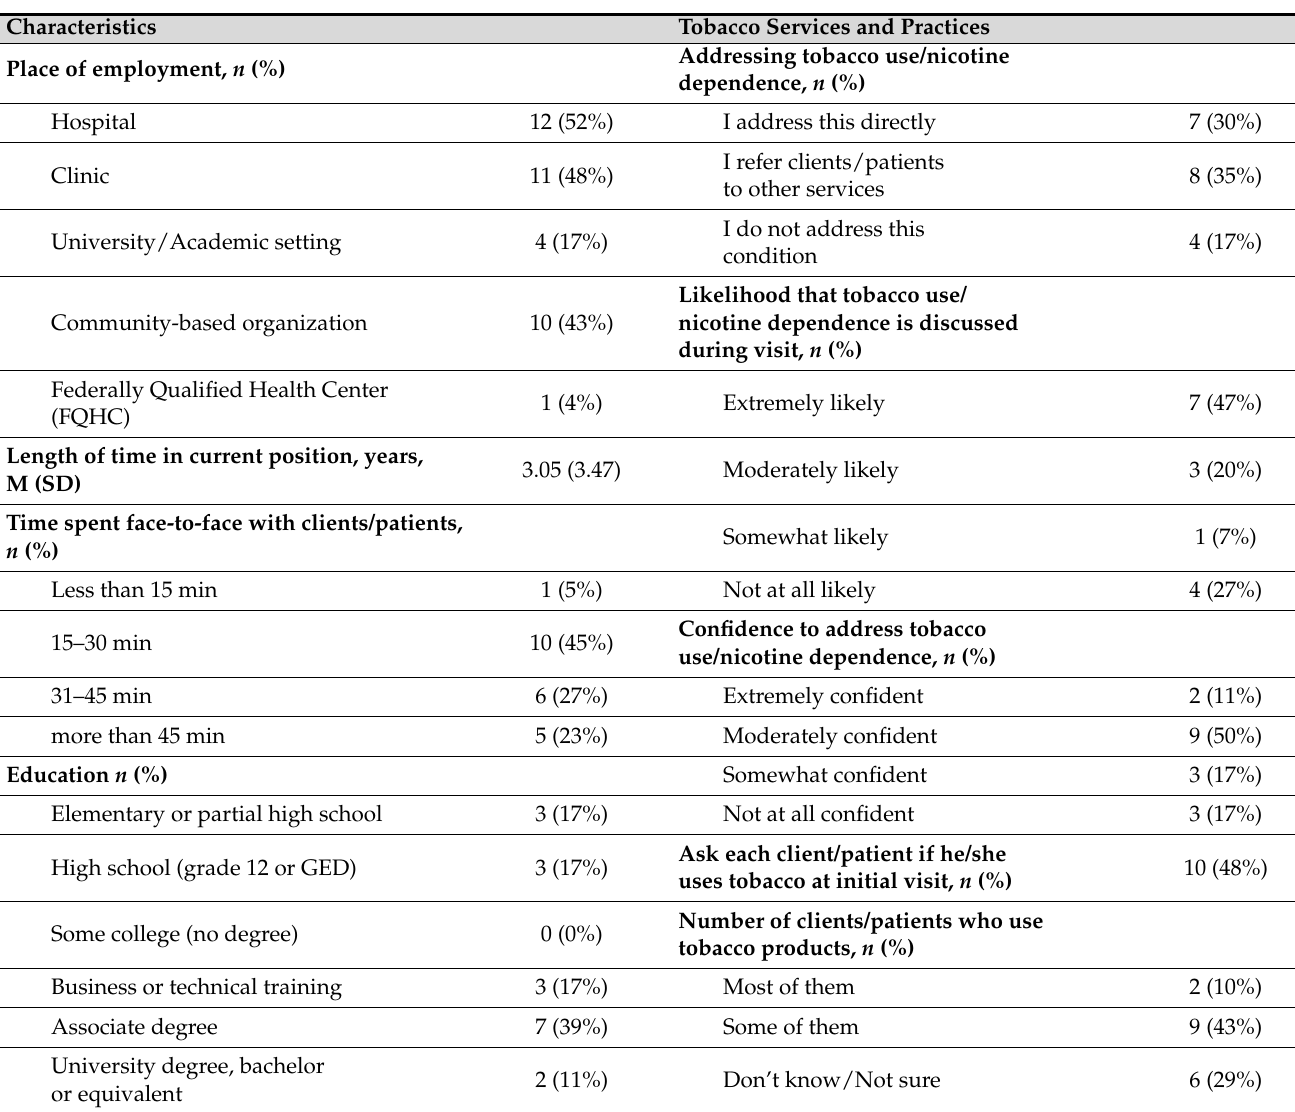
Table A1. Sample characteristics of the Community Health Workers and needs assessment survey results on current tobacco services and